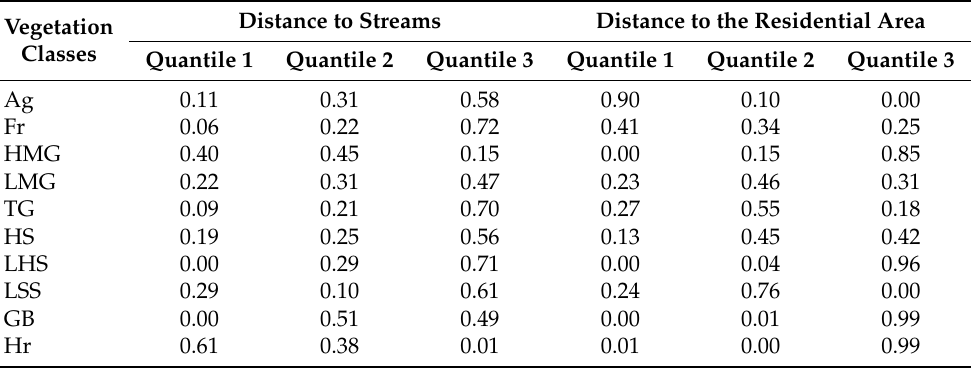
Table 4. Expert rules are based on the distance of the vegetation classes to streams and residential areas. Values describe the probability of occurrence of vegetation class at each distance quantile .